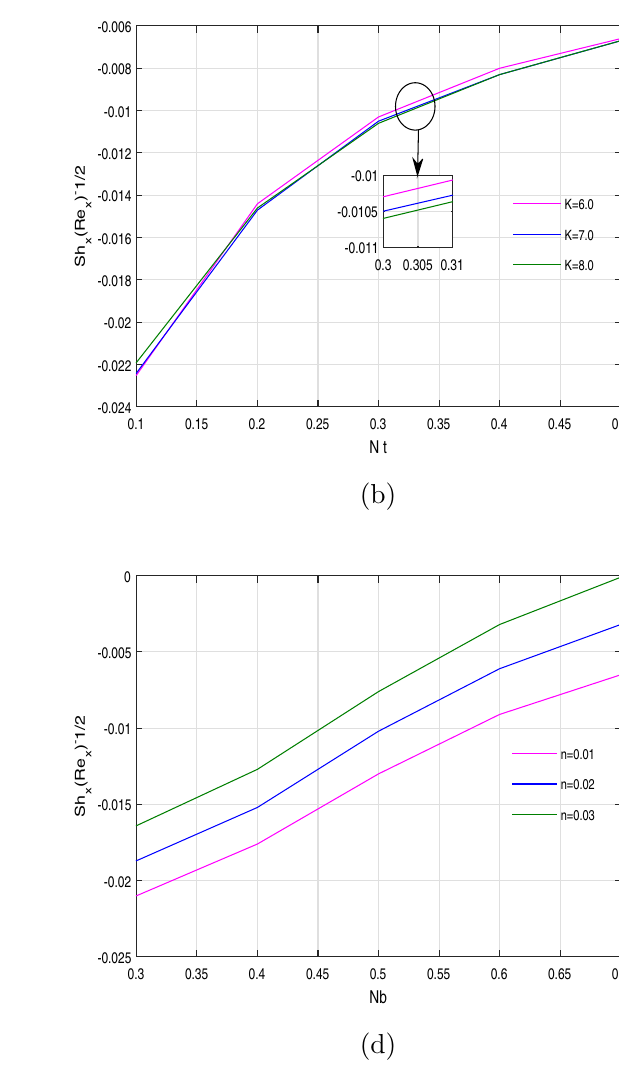
Figure 9. Variation of Sherwood number against different physical